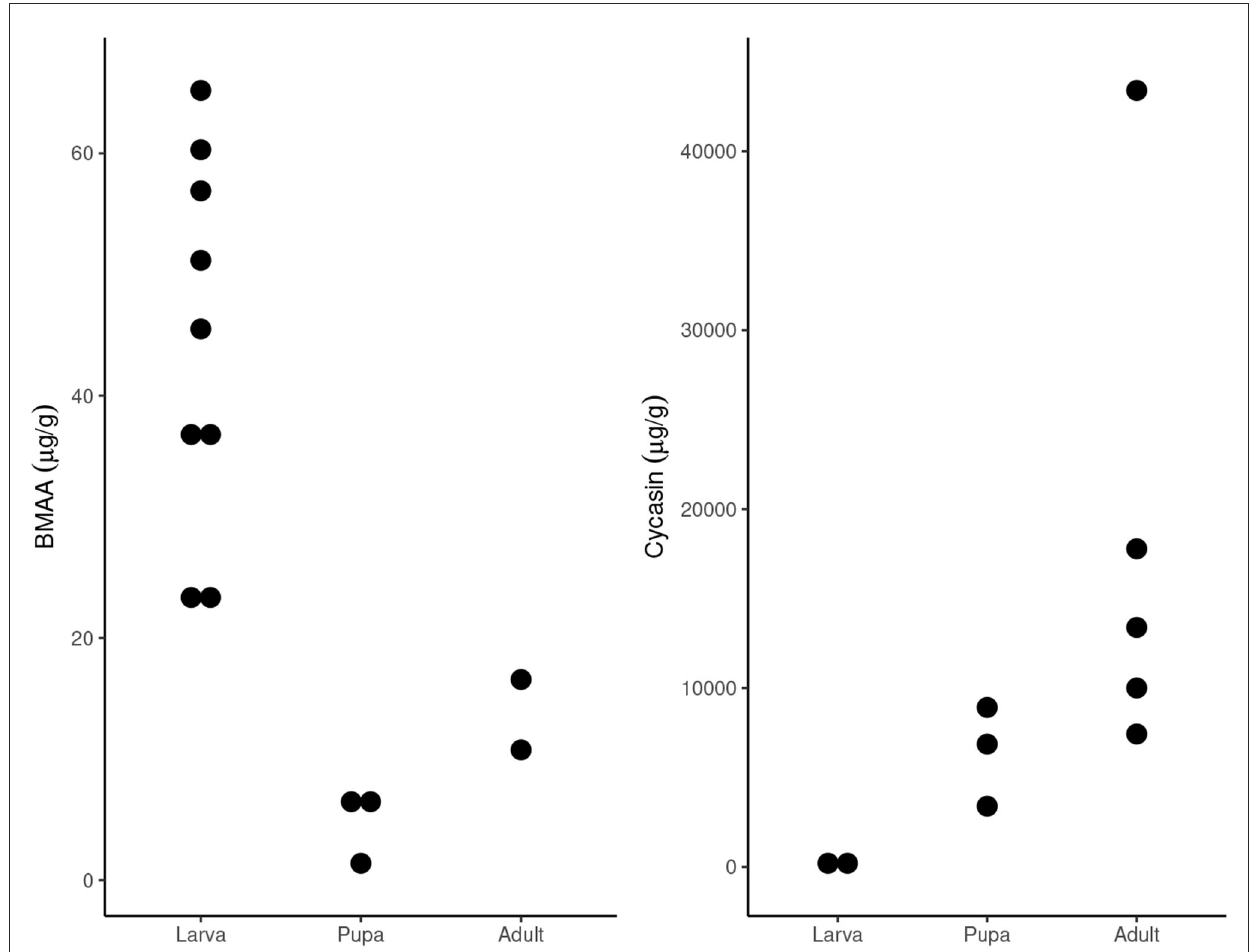
FIGURE2 Concentrations of total BMAA (left) in Eumaeus atala , compared to cycasin concentrations (right) reported by Rothschild et al. (1986) (right) , show different patterns of toxin accumulation across development. Note the different y-axis scales. All larvae and pupae samples were whole and unpooled, such that each point represents one individual. Adults subjected to BMAA analysis were dissected and pooled by sex and tissue, and BMAA quantities of all tissues were summed to calculate BMAA quantities in whole adults, such that each point represents 6 pooled individuals of the same sex. Adults subjected to cycasin analysis were dissected but not pooled, such that each point represents the summed tissues of one